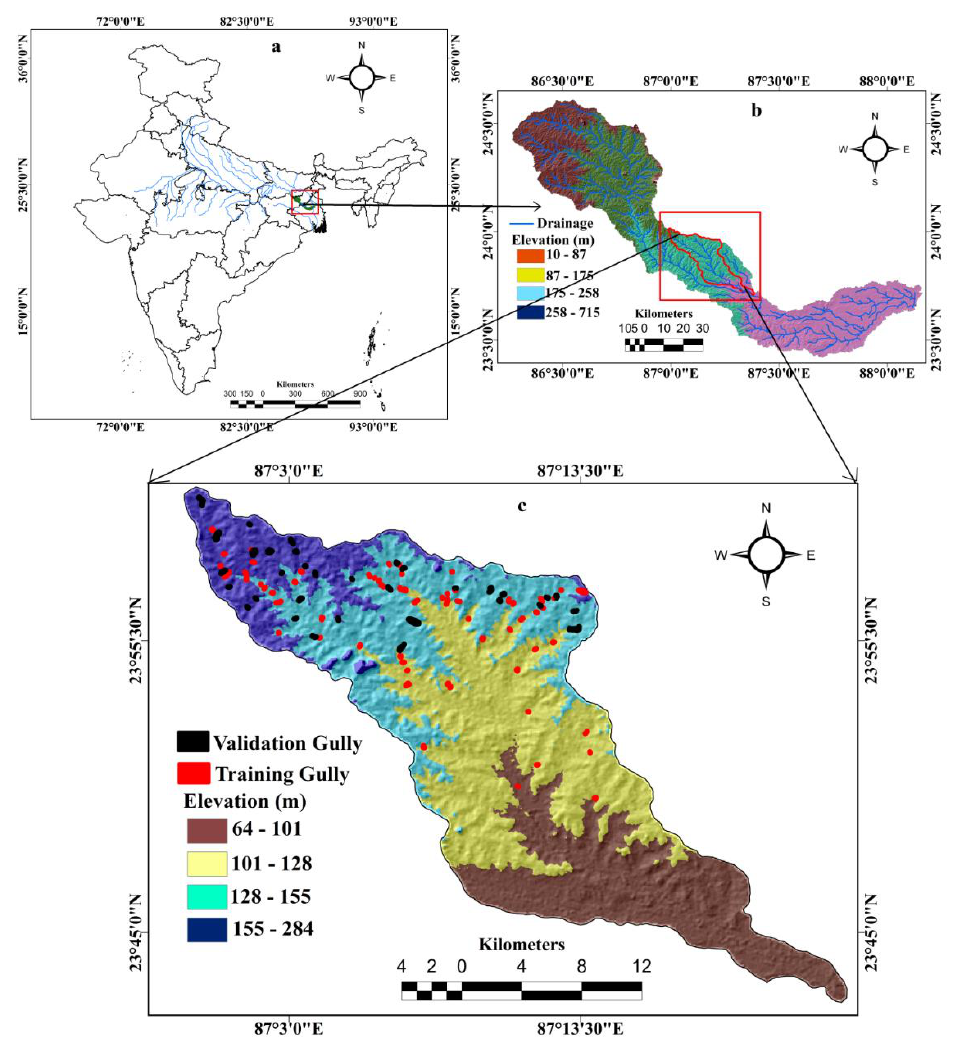
Figure 1. Study area showing ( a ) India, ( b ) Ajay River Basin, ( c ) Hinglo River Basin.